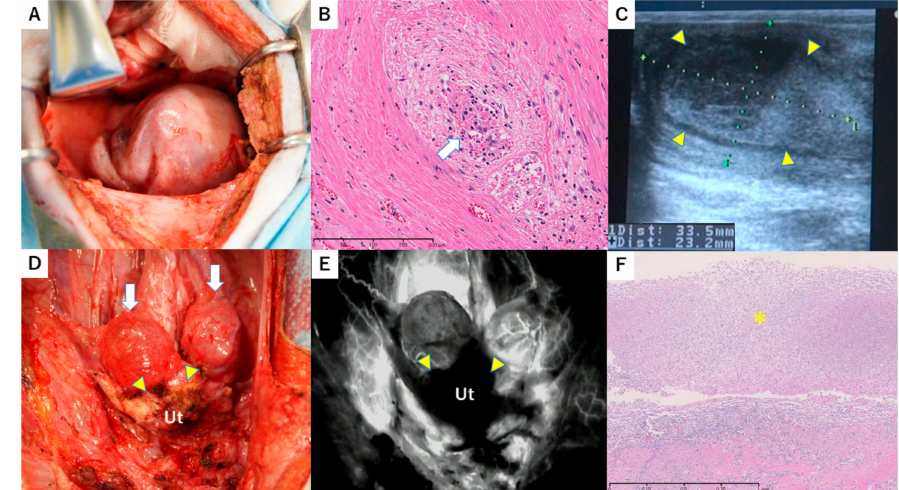
Figure 3. Macroscopic and histopathological findings in case 2. ( A ) Macroscopic findings in the